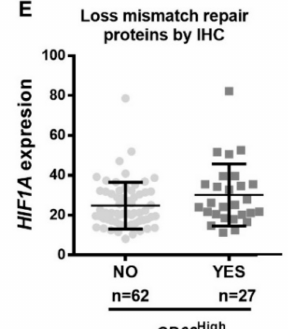
Figure 7. The pressure of hypoxia on macrophages at the consensus molecular subtype 1–microsatellite instable (CMS1–MSI)-immune colon cancer type. Microarray and RNASeq expression data